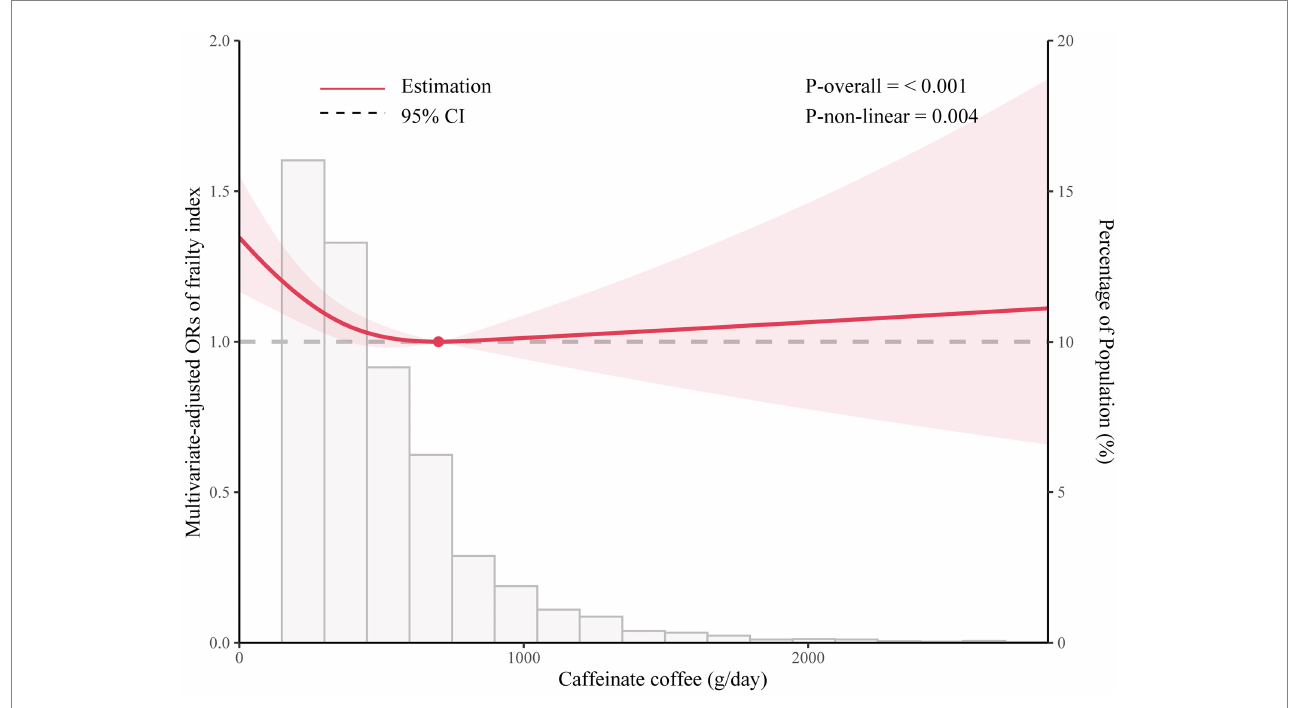
FIGURE 2 Dose–response relationship between caffeinated coffee intake and frailty.